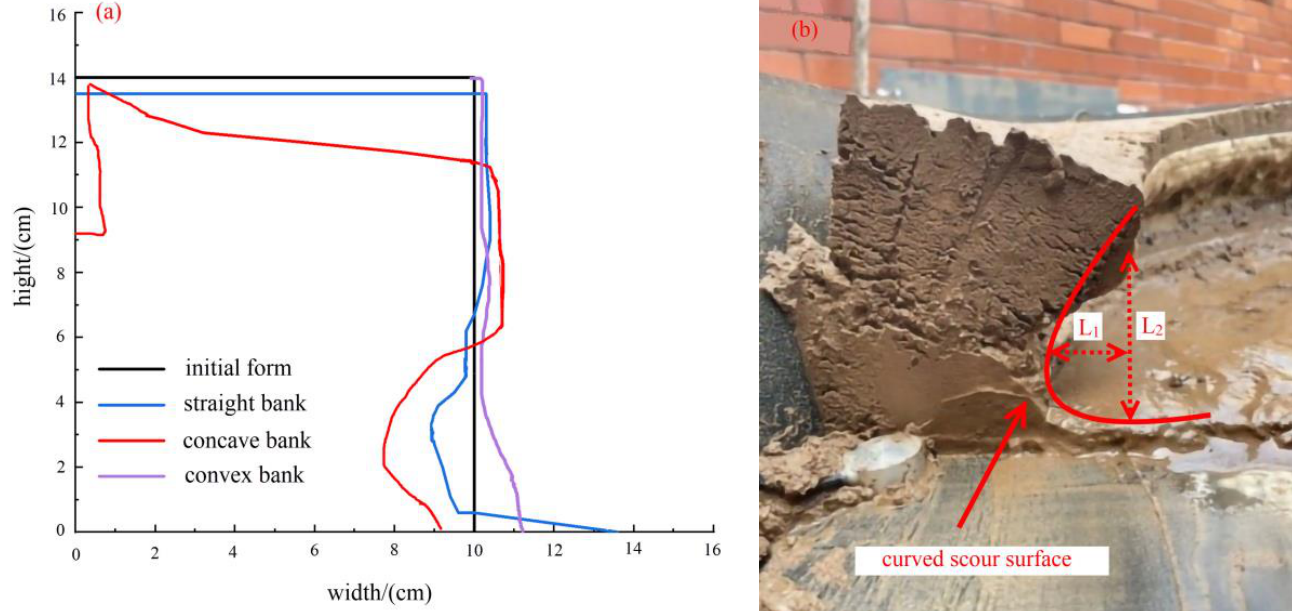
Figure 6. Bank failure pattern: ( a ) failure schematic diagram of slopes under working condition 2; ( b ) actual diagram of the concave bank under working condition 2 (L 1 : the scour height, L 2 : the scour width).